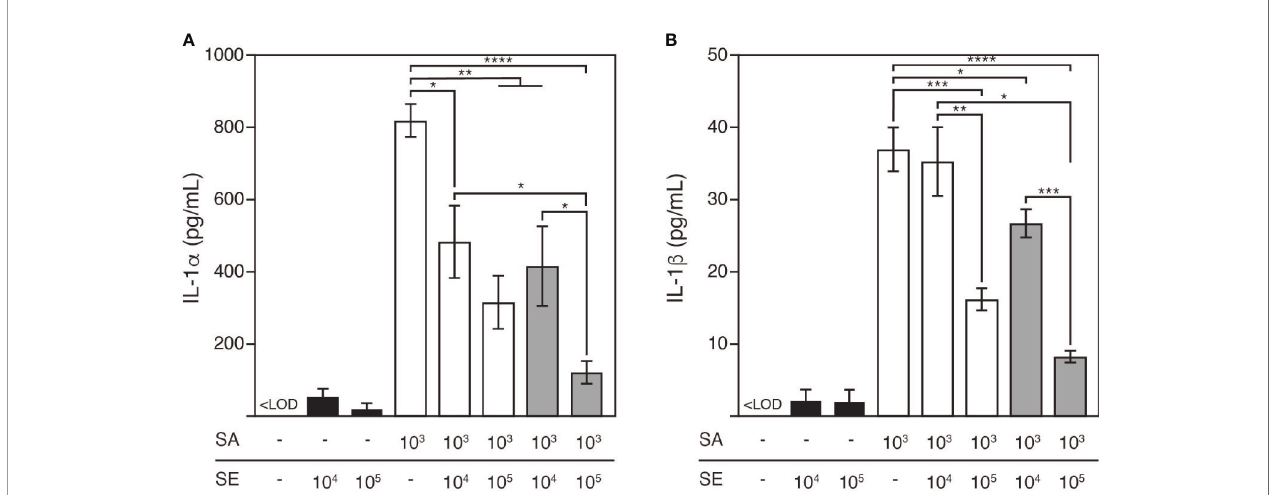
FIGURE 4 | Release of pro-in fl ammatory cytokines, IL-1 a (A) and IL-1 b (B) in response to S. aureus and/or S. epidermidis colonization after 48h cultivation. S. aureus colonization led to signi fi cant release of IL-1 a and IL-1 b from the keratinocytes, which was reduced by the colonization of S. epidermidis to an increasing degree as S. epidermidis was inoculated at a greater infective dose or prior to S. aureus . LOQ, limit of quanti fi cation; SE, S. epidermidis (black bars); SA, S. aureus (open bars). Light grey bars: S. epidermidis and S. aureus were inoculated simultaneously; dark grey bars: S. epidermidis was inoculated 4h prior to S. aureus . Data are presented as mean ± S.E. (n = 3-6). *p ≤ 0.05, **p ≤ 0.01, ***p ≤ 0.001, ****p ≤ 0.0001. Tukey – Kramer Post Hoc test after One-way analysis of variance